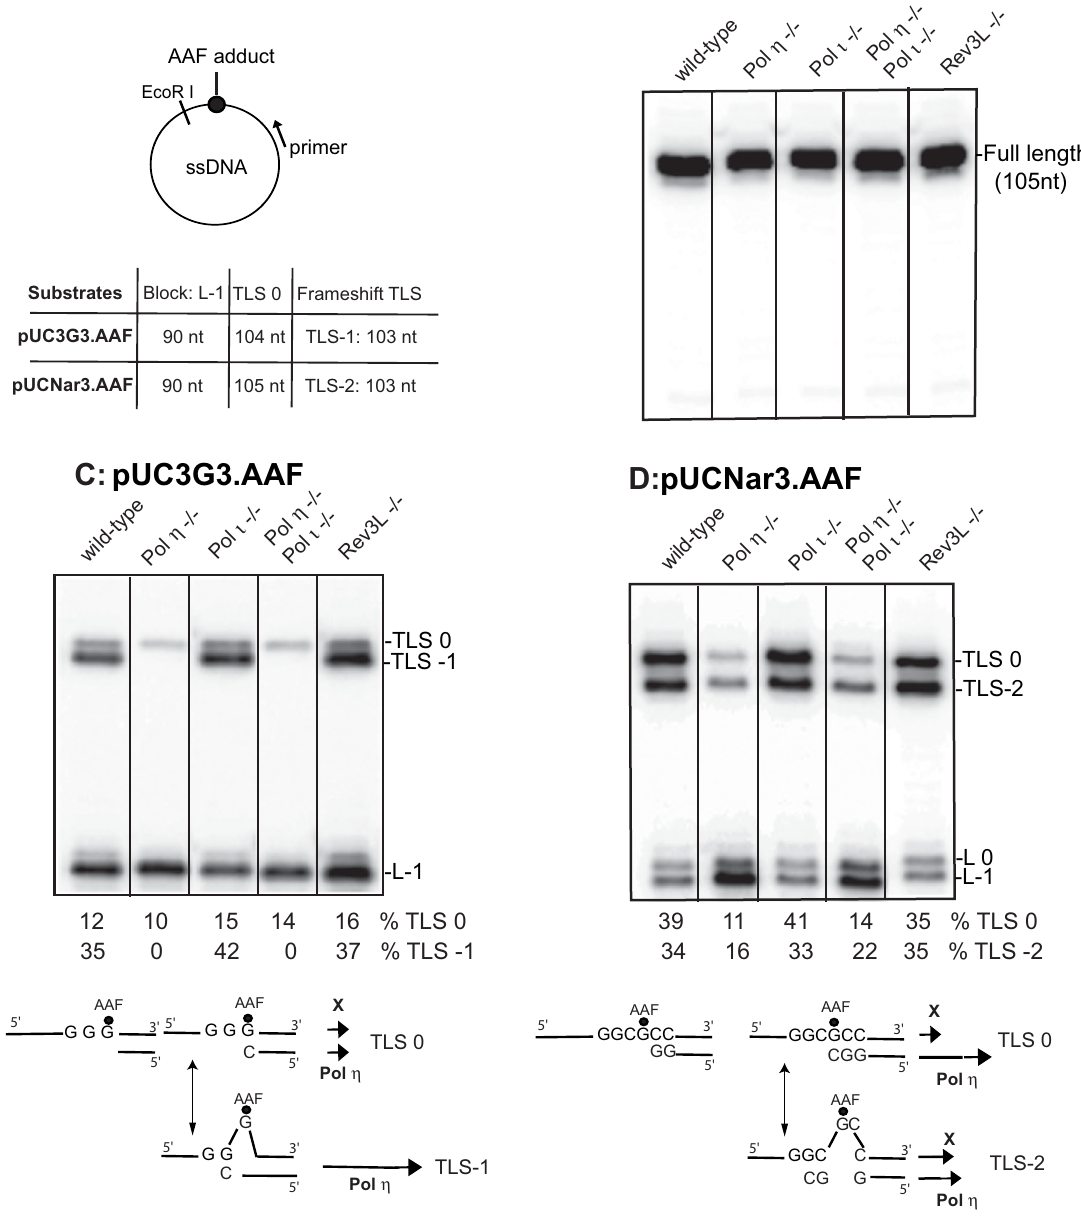
Figure 1. TLS through the G-AAF adduct in the Pol h, Pol i and Rev3 mutant BL2 cell-free extracts. Diagram of the AAF-modified plasmids (panel A). Lengths of the strands produced upon elongation of the labeled primer are indicated; nt, nucleotides. 10 fmoles of unmodified DNA (panel B) or AAF-modified substrates (panels C and D) were incubated 30 min at 37 u C in the presence of BL2 cell-free extracts (15 mg) in a final volume of 6.25 ml, as indicated. The samples were analysed by electrophoresis through a 8% denaturing polyacrylamide gel. L-1 and L0 are products generated if synthesis is blocked one nucleotide before and opposite the lesion, respectively. TLS0 and TLS-1 or –2 are products from TLS via non- slipped and slipped intermediates, respectively. Models for the bypass of the AAF lesion in the two sequence contexts are shown below each gel. The length of each arrow is proportional to the involvement of the different factors. doi:10.1371/journal.pone.0036004.g001 peptide was then immobilized on Dynabeads His-Tag para- After magnetic separation, the supernatant was filtered through magnetic beads (Invitrogen) according to the manufacturer’s Ultrafree MC 0.45 m m HV Durapore filters (Millipore). The instructions (500 m g of peptide per 3 mg of beads). After extensive efficiency of the depletion was checked by Western blotting. washes, the beads were mixed with 5 mg of cellular extracts in 850 ml of DIA buffer (100 mM potassium glutamate, 30 mM HEPES pH 7.9, 1 mM DTT, 10% glycerol) containing 50 mM NaCl and incubated for 1 hour at 4 u C with continuous rotation.